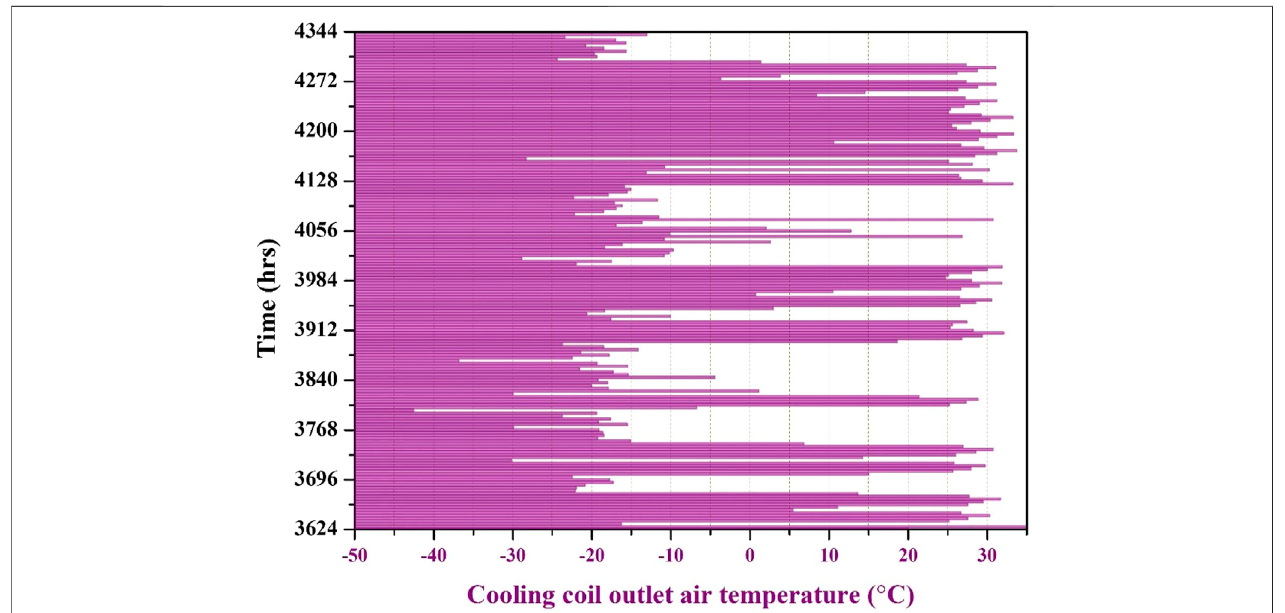
FIGURE 7 | Cooling coil outlet temperature ( ° C).